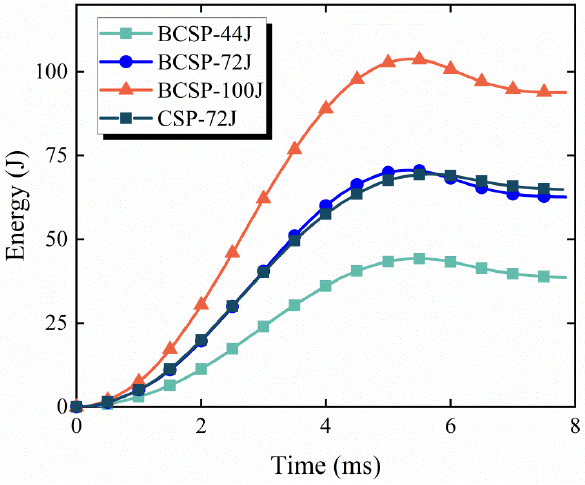
Figure 11. Absorbed energy – time curves of the